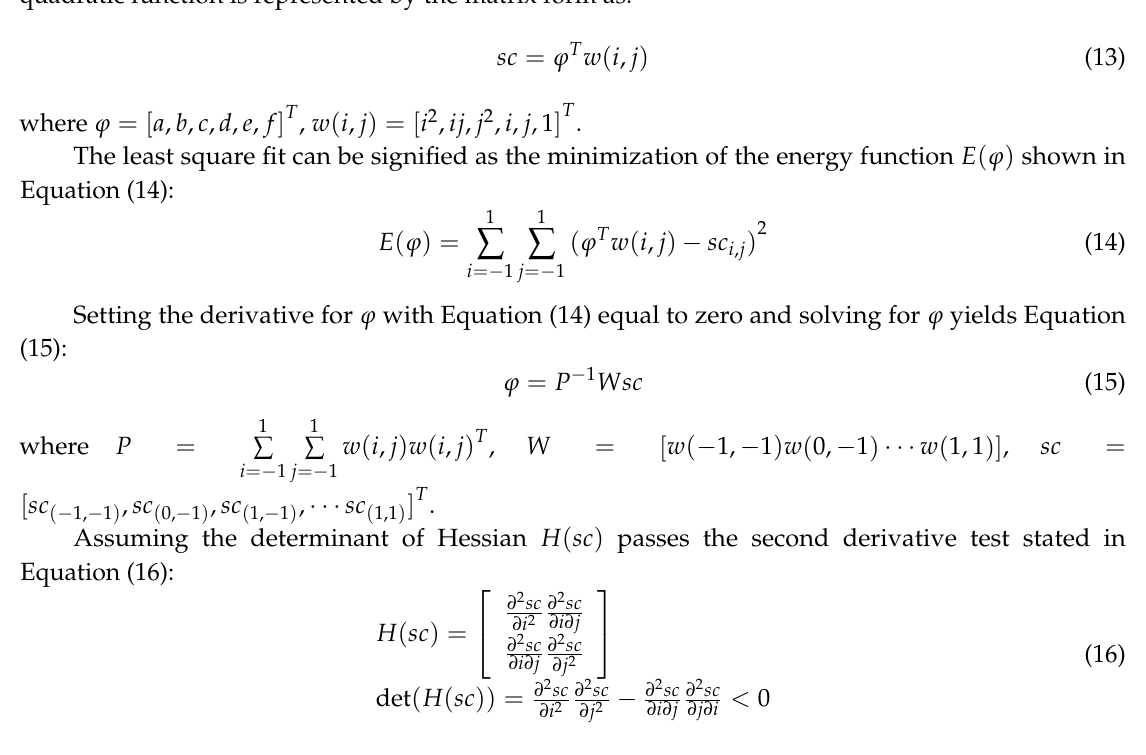
Figure 4. A FAST-BRISK 3 3 ´ score patch.